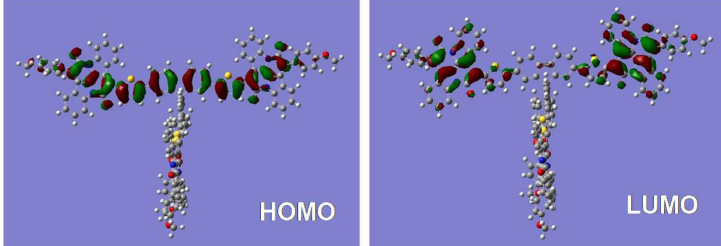
Figure 3. The calculated HOMO and LUMO orbital plots of